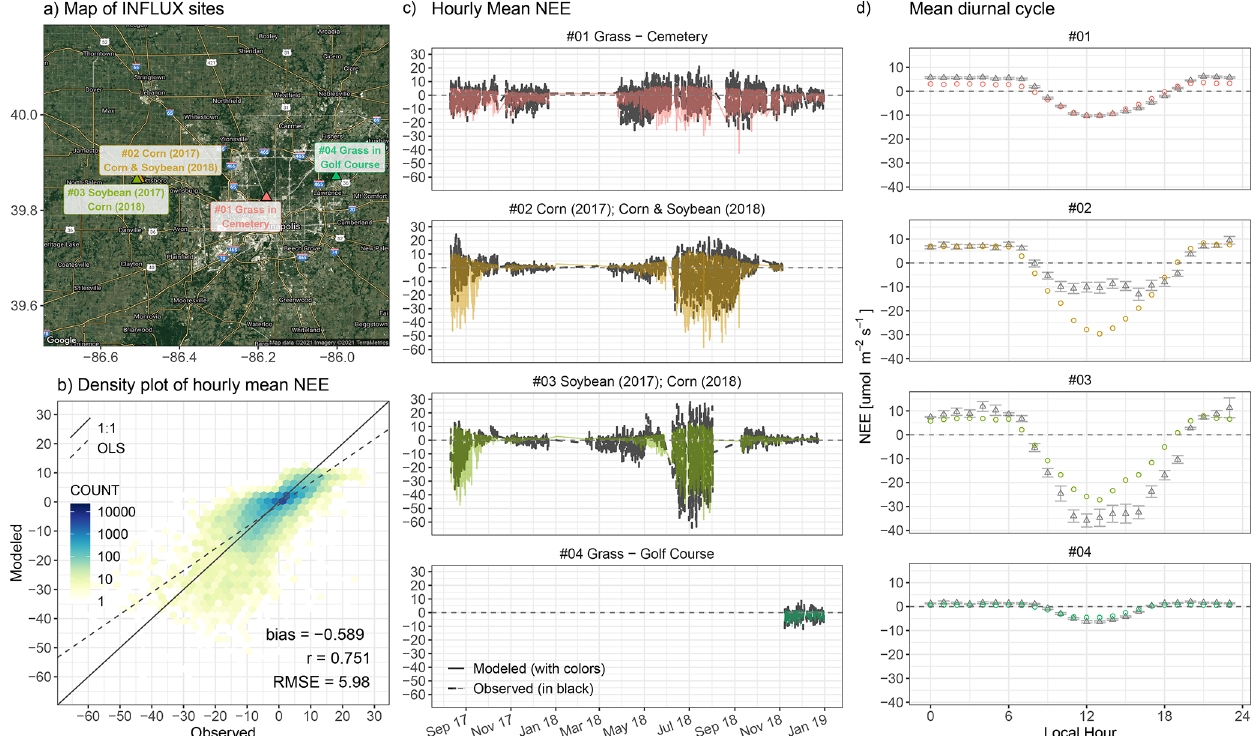
Figure 10. NEE flux evaluation based on four EC towers from the INFLUX network around Indianapolis (a) . Model–data flux comparisons at the hourly scale [µmolm − 2 s − 1 ] from August 2017 to December 2018 are shown as a density plot (b) and time series (c) . Error statistics in hourly NEE including the mean bias, correlation coefficient ( r ), and root mean square error (RMSE) are printed in the bottom right corner of panel (b) . (d) Mean diurnal cycle of observed NEE (black triangles) and modeled NEE (colored circles) over JJA for two cropland sites (sites no. 2 and no. 3) and the entire year of 2018 for urban vegetation sites (sites no. 1 and no. 4). For panel (c) and (d) , model fluxes are shown as solid lines or circles with four colors indicating different sites, whereas measured fluxes are shown as black dashed lines or triangles. Supplementary information on the spatial map of modeled NEE and monthly mean NEE comparisons can be found in Fig. S12. Note that the underlying hybrid satellite image in panel (a) was generated using the ggmap R library with Google Maps (Map data © 2021 Imagery © 2021